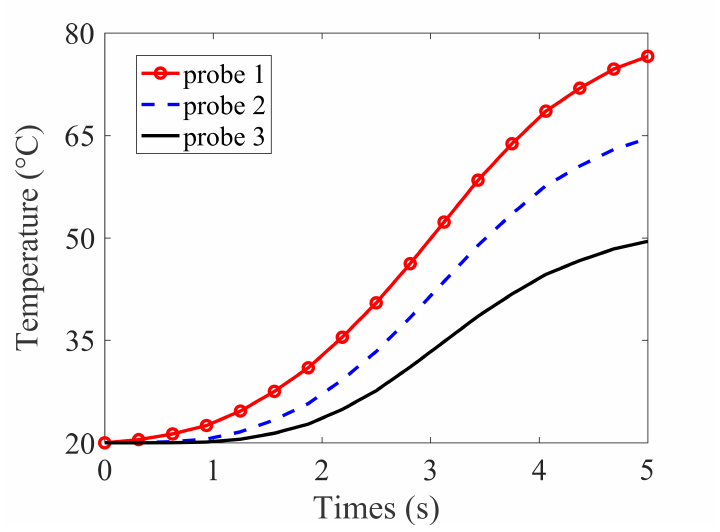
Figure 5. Temperature changes on three probes on the CPU inside the